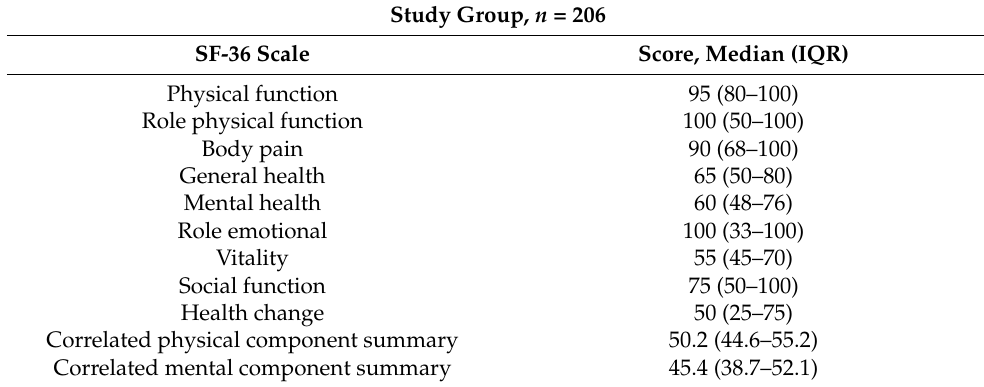
Table 5. Quality of life (SF-36 scores) in outpatients who had recovered from